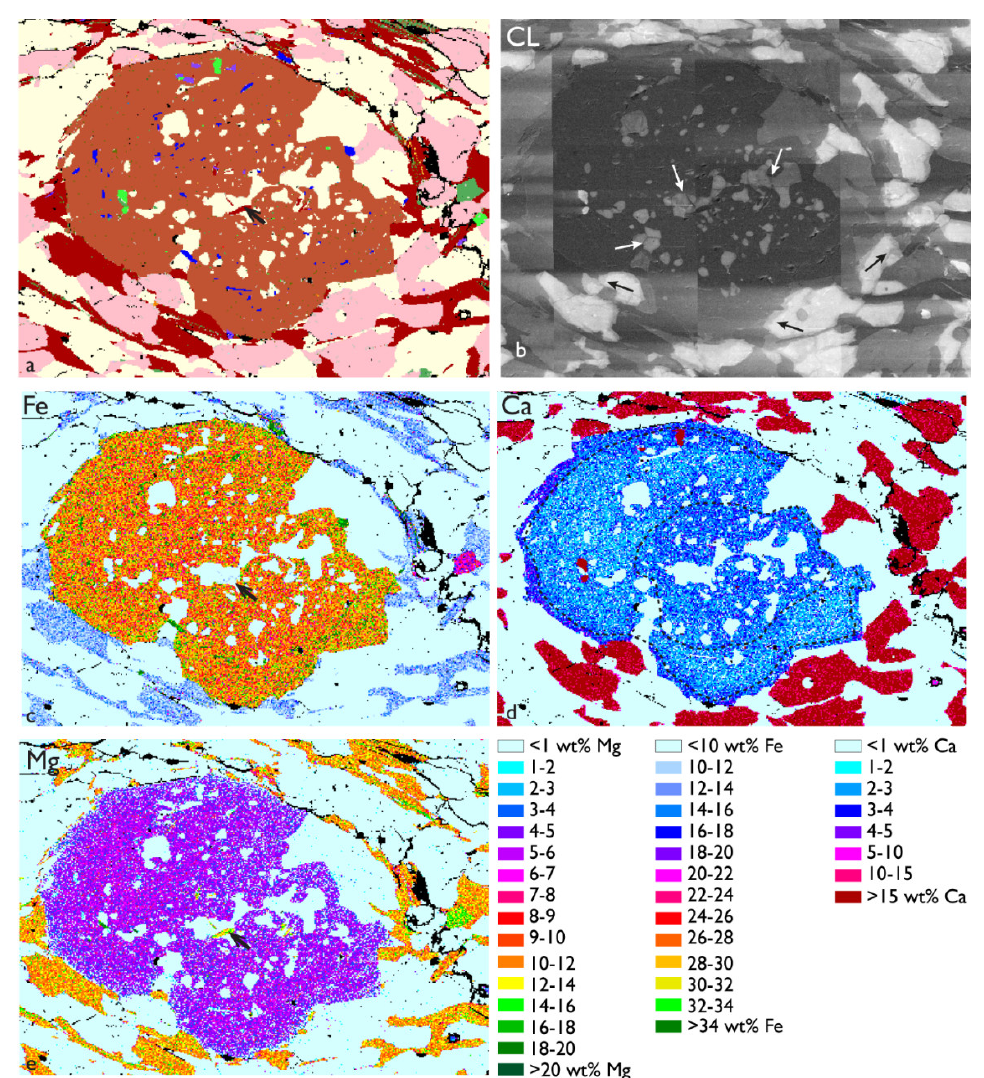
Figure 7. Detailed maps and image of the central garnet in Figure 6. ( a ) Mineral map. See Figure 6 for a legend of the colours applied. ( b ) Cathodoluminescence image mosaic of the same garnet. White and black arrows point to growth features in anorthite and quartz, respectively. ( c ) Mg element concentration map. ( d ) Ca element concentration map with black contours indicating the weak zonation in garnet. ( e ) Fe element concentration map. Arrows in (c) and (e) point to an example of an included biotite grain with different Mg–Fe ratios.